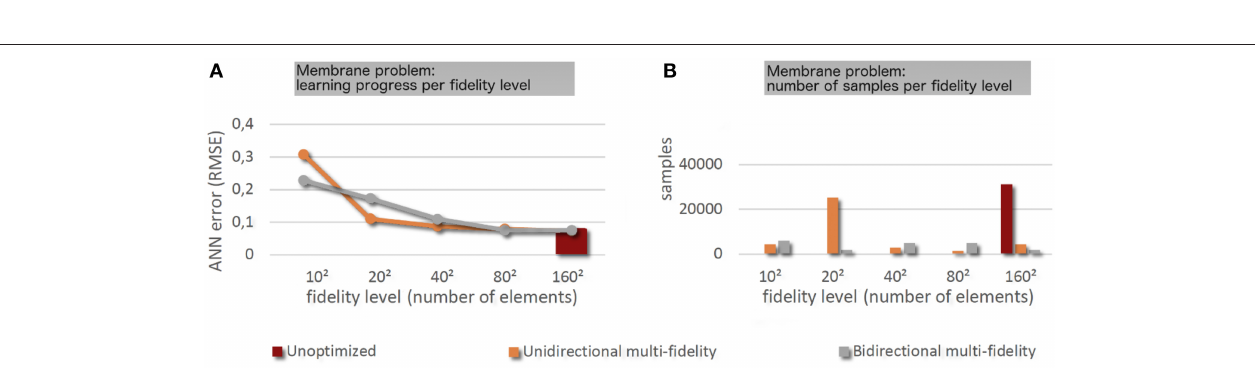
lower average computational cost of the samples used. Figure